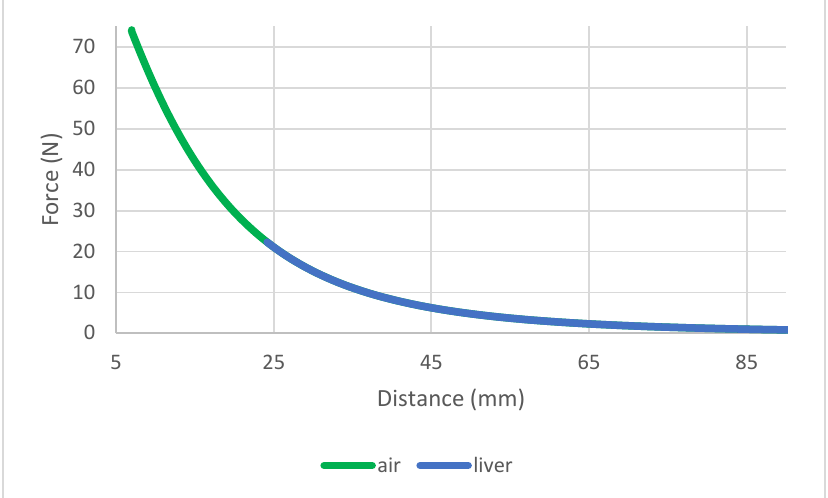
Figure 11. Force curve between a 45 kg pull-force neodymium magnet and a 25 kg pull-force neo- dymium magnet as the target specimen with and without placing a 20 mm-thick bag of diced chicken liver in between. Results show no significant difference regarding the magnetic properties of the two materials.